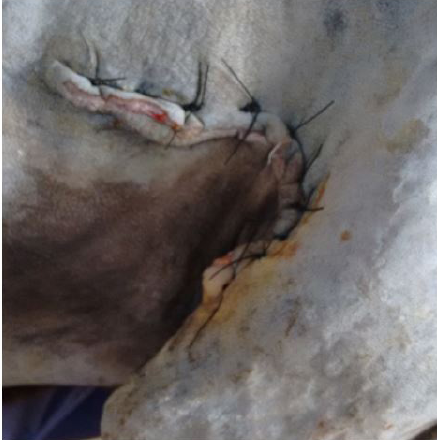
Figure 6. Accessory limb attachment site after